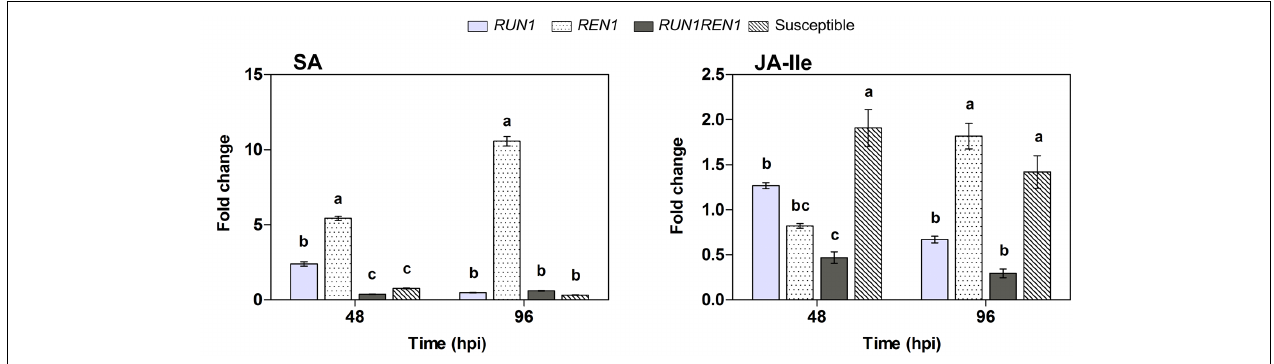
FIGURE 9 | Analysis of salicylic acid (SA) and jasmonoyl-isoleucine (JA-Ile) levels in response to E. necator . Samples were collected at 0, 48, and 96 hpi; data were normalized to uninfected controls (0 hpi). Data points represent means ± SEM considering three biological replicates. Different letters indicate statistically significant difference between genotypes as determined by Bonferroni’s multiple comparison test ( P ≤ 0.05).